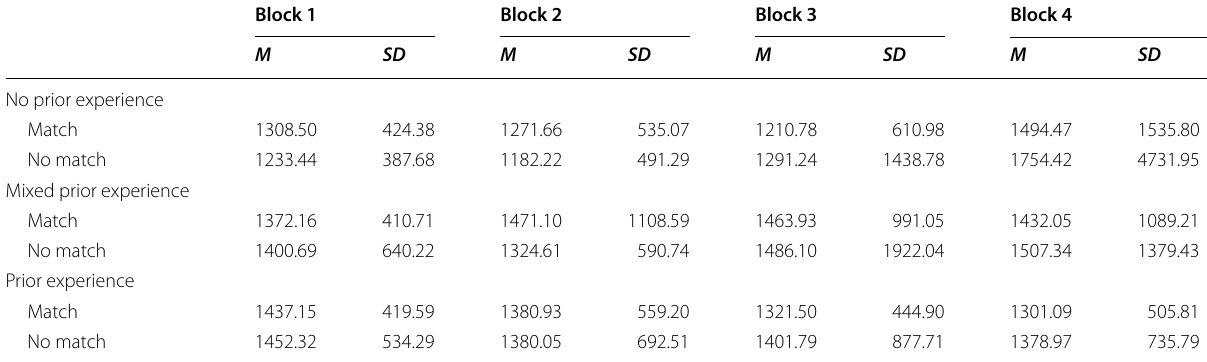
Table 5 Ongoing task response time across blocks by experience condition in Experiment 2